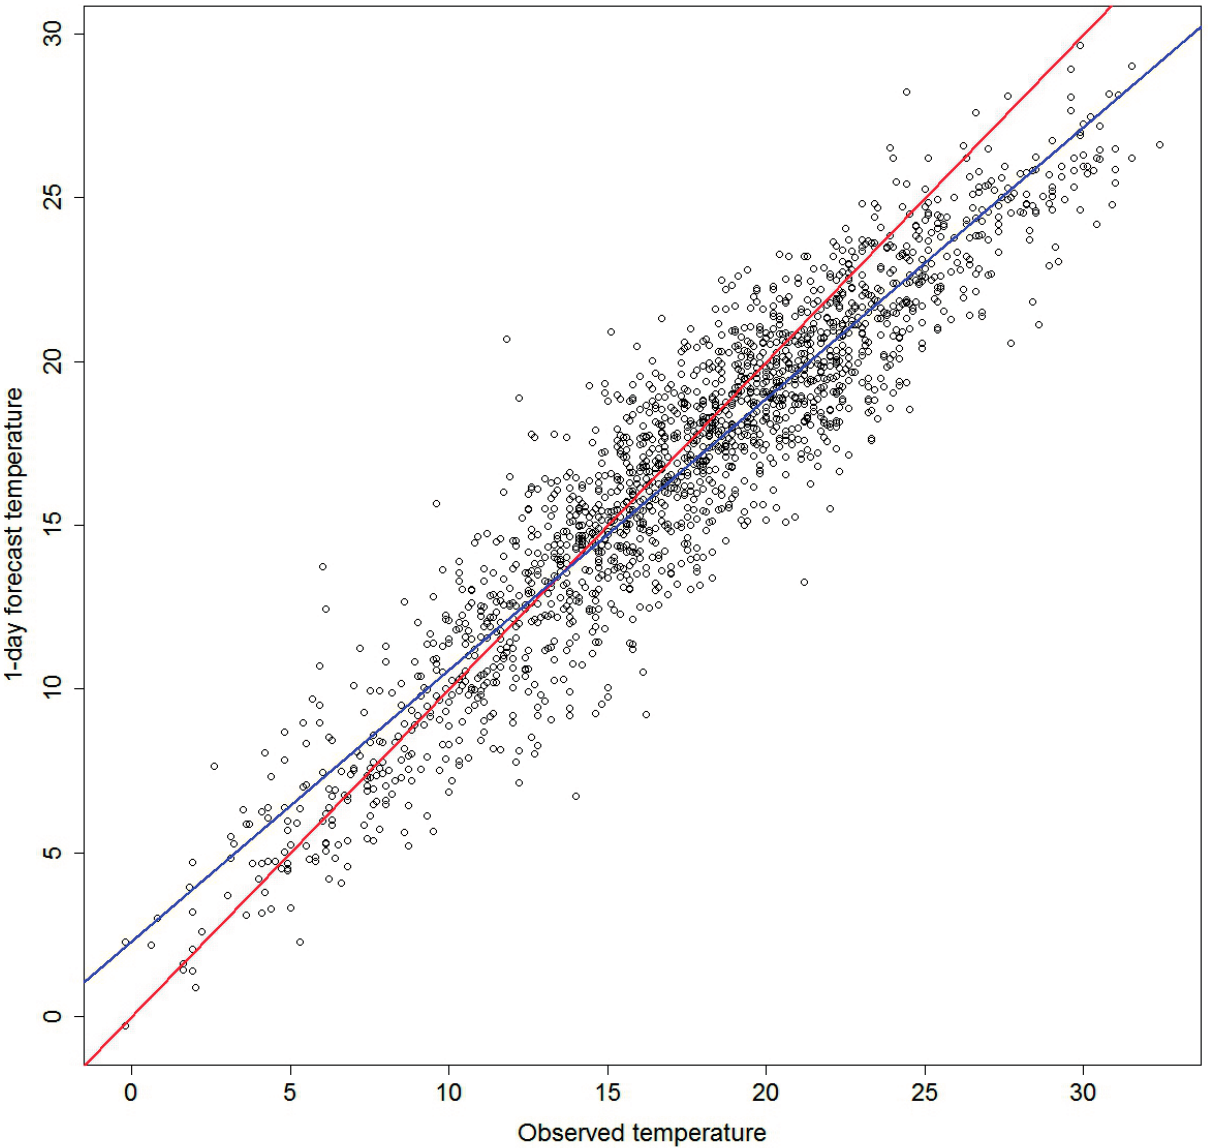
Figure 1. Observed vs. 1-day forecast temperatures, Stockholm, 1998–2007. Red